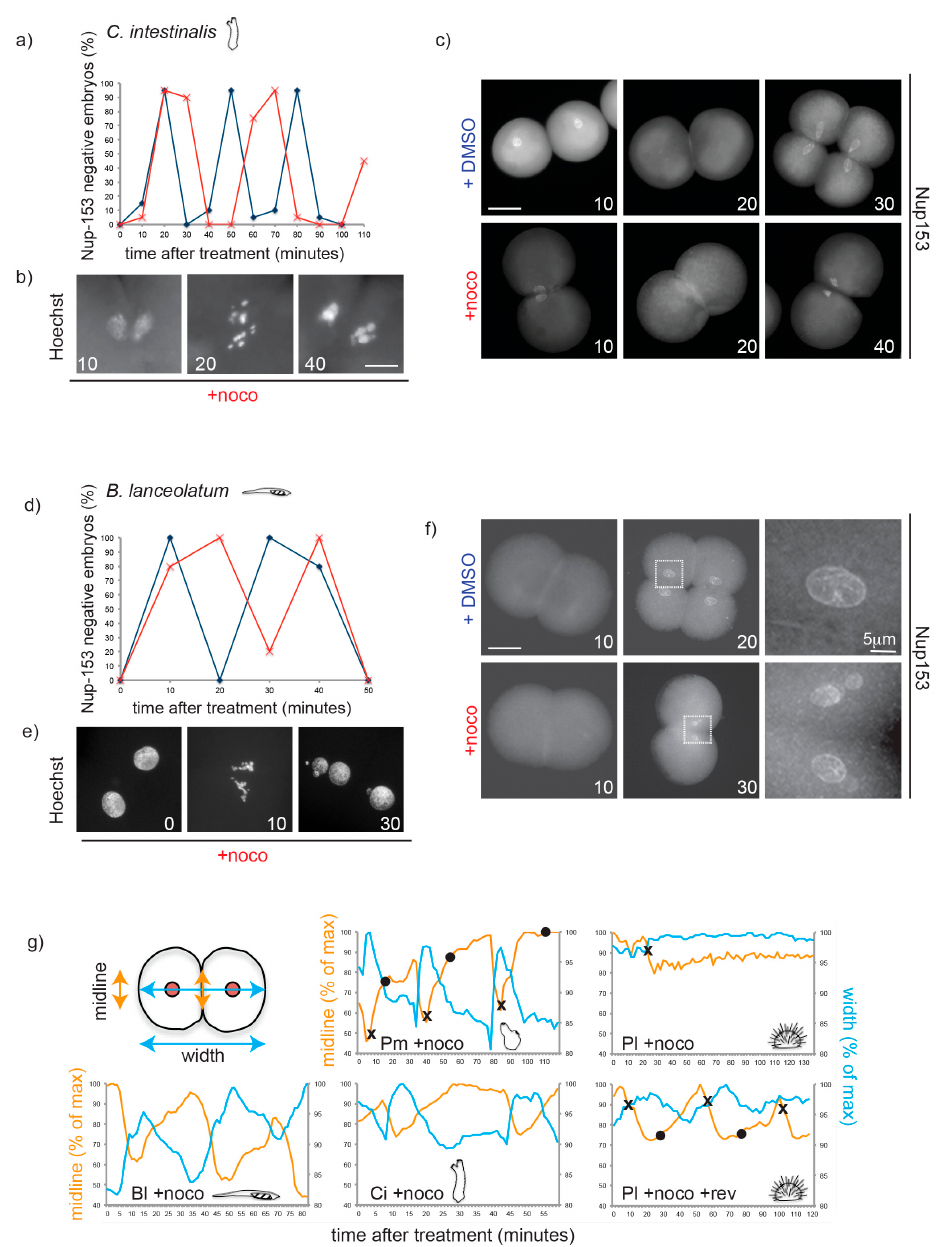
Figure 4. Nocodazole treatment does not delay mitotic progression during cleavage in chordate embryos. ( a ) Quantification of Nup153-negative C. intestinalis embryos (without nuclei = mitosis) in the presence of DMSO (blue) or nocodazole (red) over the time of 3 divisions (2–16 cells). Representative of 3 independent experiments. n = 20–30 embryos for each time point. ( b ) Representative C. intestinalis Hoechst-stained nuclei and ( c ) Nup-153-stained embryos. ( d ) Percentage of B. lanceolatum embryos without nuclei, as determined by Nup-153 staining, in the presence of DMSO (blue) or nocodazole (red) over the time of two divisions (2–8 cells). Representative of 3 independent experiments. n = 50–100 embryos per time point. ( e ) Representative B. lanceolatum Hoechst-stained nuclei and ( f ) Nup-153-stained embryos. Numbers indicate minutes after treatment. ( g ) Measurement of long axis of embryo (width, blue) and cell–cell contact region (midline, orange) during 2–3 cell cycles in a representative embryo of B. lanceolatum (Bl), P. mammillata (Pm, see movie 1), C. intestinalis (Ci), and P. lividus (Pl) in the presence of nocodazole ( + noco; movie 2) or for Pl nocodazole / reversine (Pl + noco + rev; movie 3). Measurements are reported as percentage of maximum length throughout the recording. Crosses ( × ) correspond to NEB, and circles ( • ) to NER. Scale bar = 30 µ m, unless otherwise